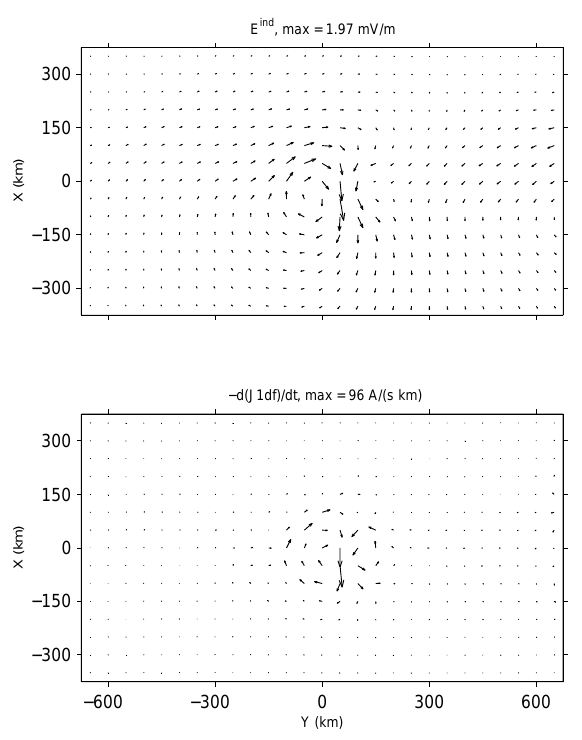
Fig. 10. Comparison between the induced electric field (same as in Fig. 8) and negative time derivative of the divergence-free currents of the input